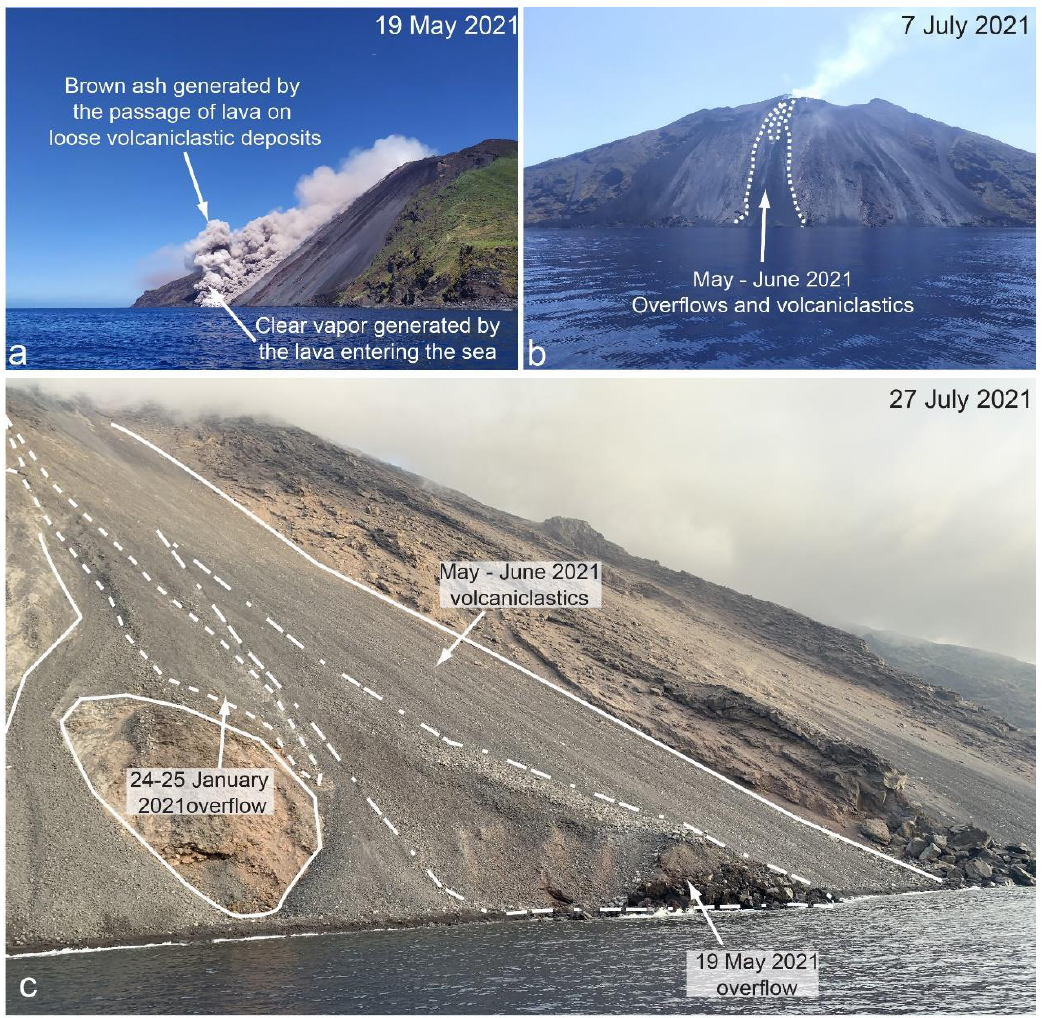
Figure 2. ( a ) 19 May 2021 oblique photo of the SdF showing the lava flows that reached the sea after the start of the overflows that caused the collapse of the NE crater-rim; ( b ) 7 July 2021 photo of the SdF showing the accumulation of lava and volcaniclastic deposits related to the eruptive activity of May and June 2021; ( c ) 27 July 2021 oblique photo of the central part of the SdF showing the remnants of the 24 – 25 January 2021 and the 19 May 2021 overflows, partially draped by the successive May – June 2021 volcaniclastic material.